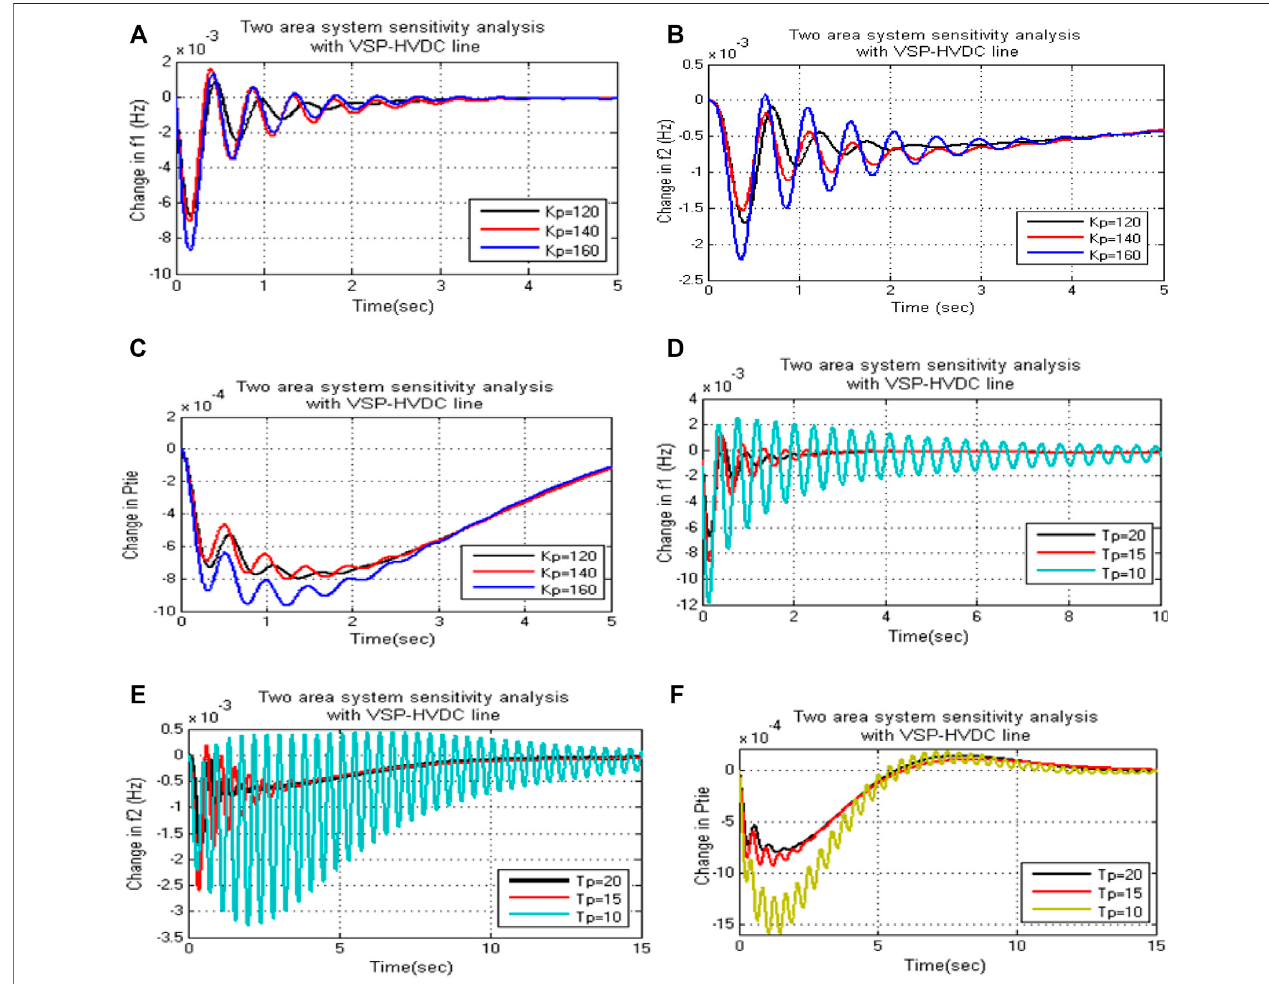
FIGURE5| Sensitivityanalysisinthepresence ofVSP-HVDClink. (A) Effect ofvariationofKponf 1 . (B) Effect ofvariationofKpon f 2 . (C) Effect ofvariationofKpon P tie . (D) Effect of variation of Tp on f 1 . (E) Effect of variation of Tp on f 2 . (F) Effect of variation of Tp on P tie .